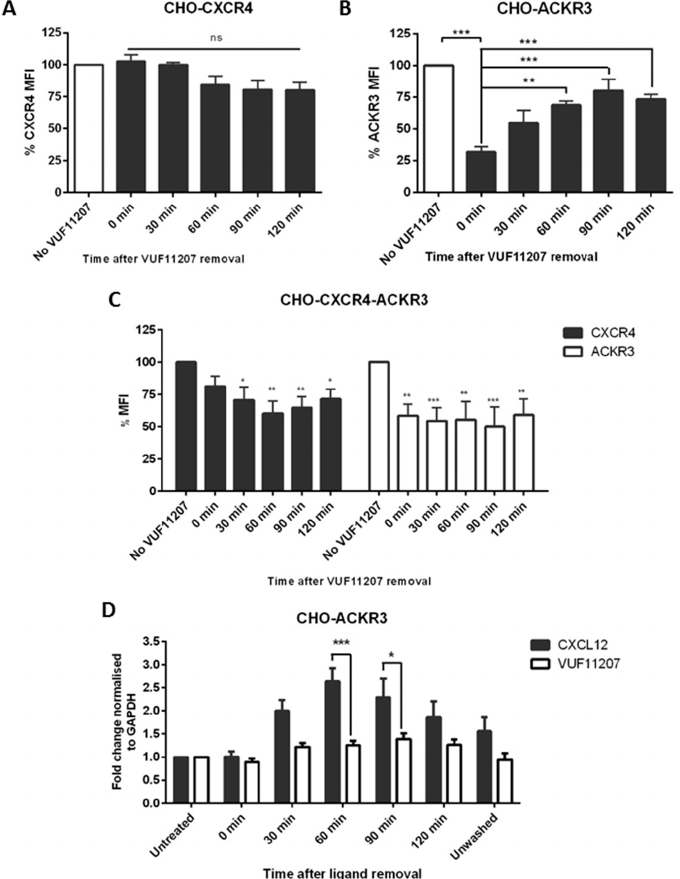
Figure 6. CXCR4 and ACKR3 follow different internalization pathways after VUF11207 stimulation. ( A ) CHO-CXCR4, ( B ) CHO-ACKR3 and ( C ) CHO-CXCR4-ACKR3 cells were stimulated with 1 nM